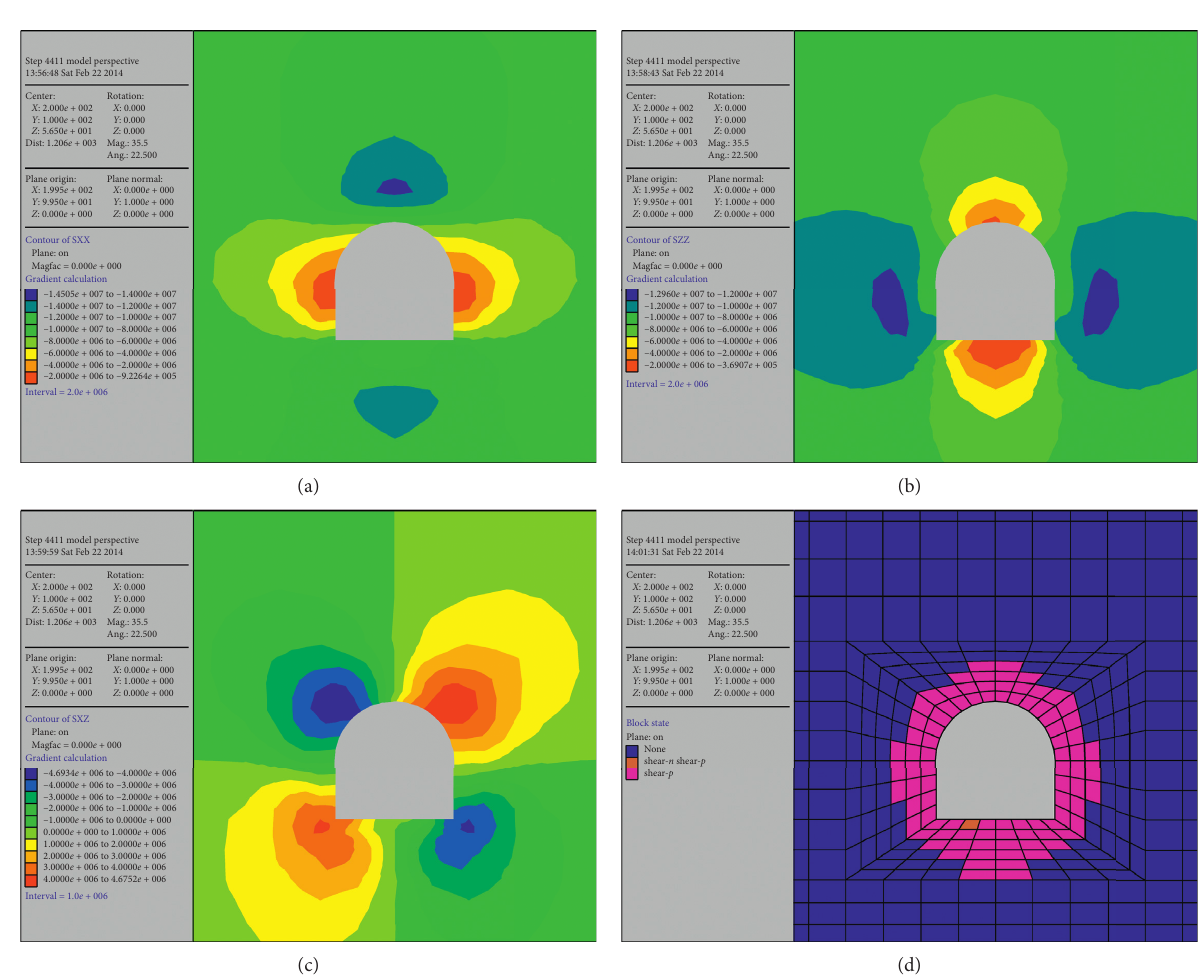
Figure 7: The stress state of the roadway after initial excavation. (a) Horizontal stress nephogram. (b) Vertical stress nephogram. (c) Shear stress nephogram. (d) Distribution of the plastic